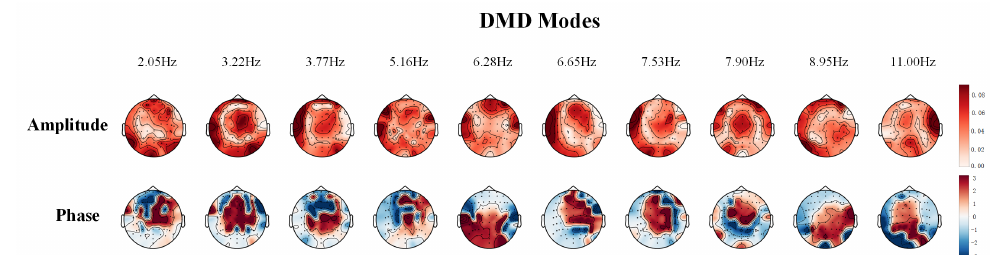
Figure 5. The distribution of amplitude and phase of DMD modes in the frequency range of 2–12 Hz. (Take the recording in session 2 of subject 3 in the monitoring error-related potentials dataset as an example).